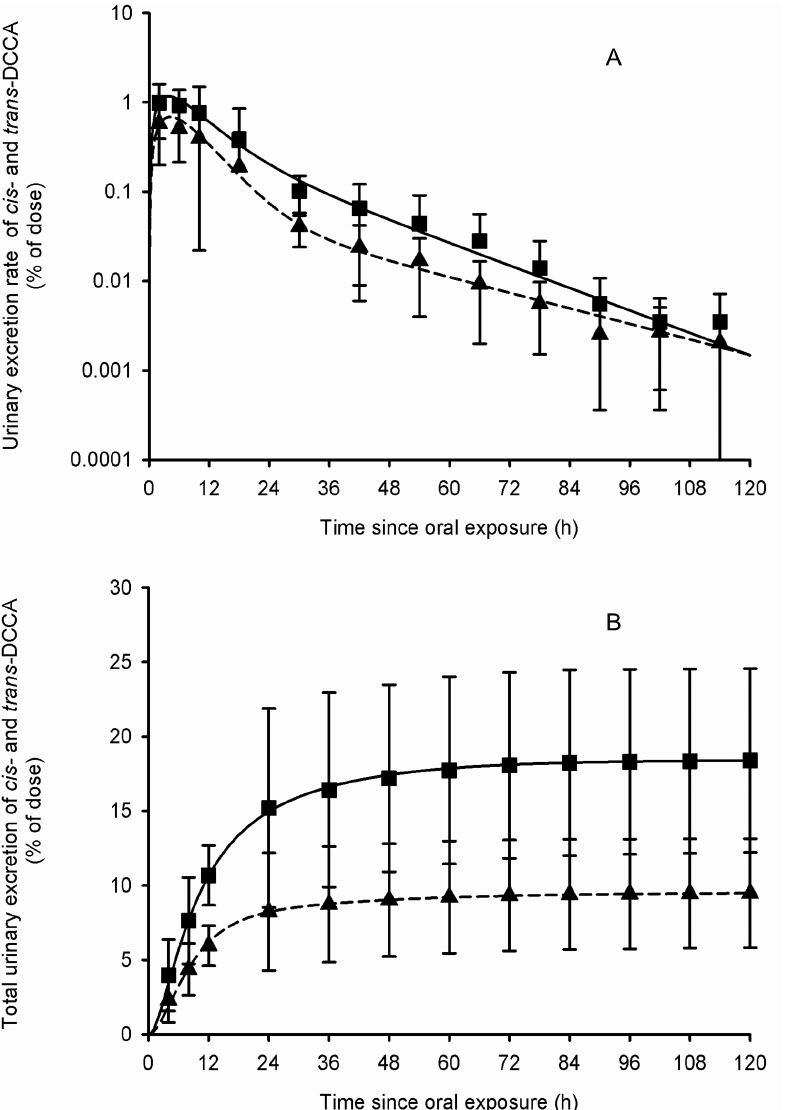
Figure 3. Comparison of model simulations with experimental data for cis - and trans -DCCA (volunteers orally exposed). Comparison of model simulations (lines) with experimental data of Woollen et al. (1992) (symbols) on the average time courses of cis - and trans-DCCA excretion rate (A) and cumulative excretion (B) (% of administered dose) in volunteers orally exposed to 3.3 mg of cypermethrin. Triangle and square symbols represent average experimental values for cis - and trans -DCCA, respectively, and vertical bars the experimental standard deviation (n=6).